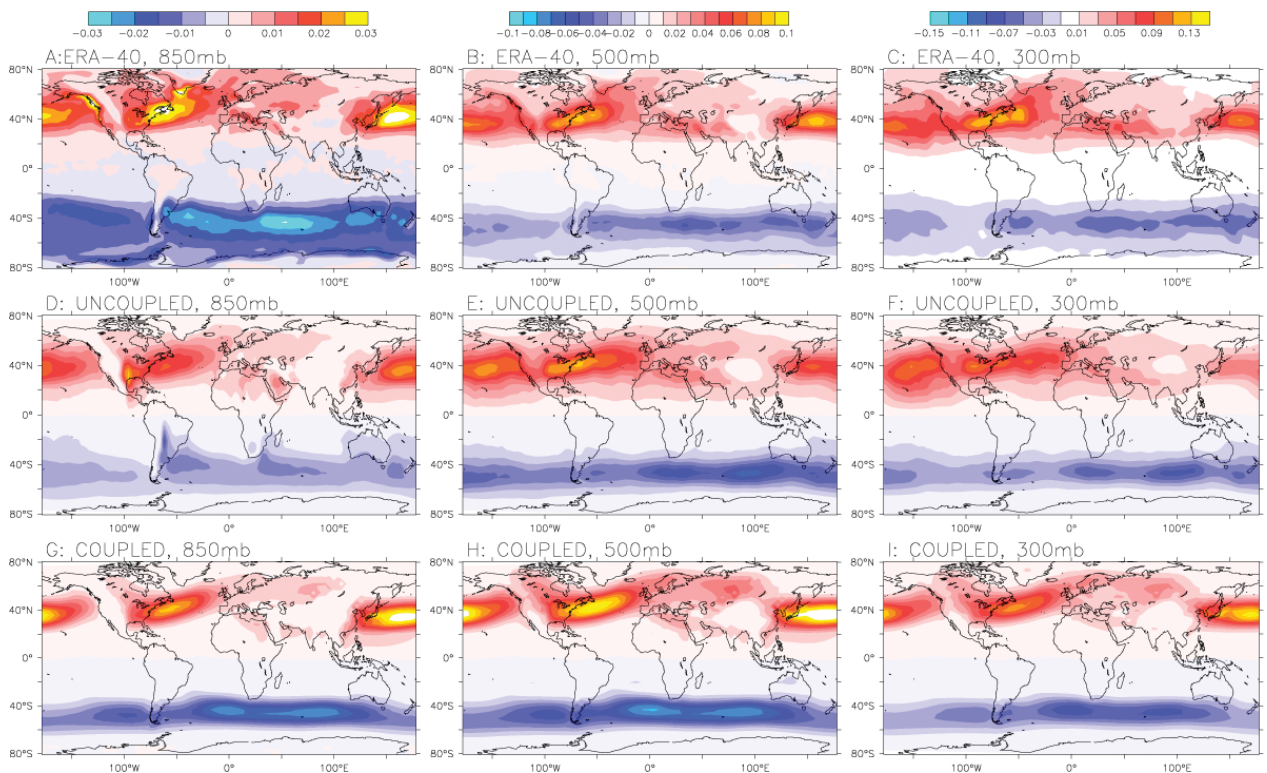
Fig. 7. Band-pass filtered ERA-40 data at (a) 850mb, (b) 500mb and (c) 300mb of h v 0 w 0 i (in m 2 s − 2 ) for December-January-February. (d–f) show results of “uncoupled” and (g–i) “coupled” experiments using Aeolus (Eq. 7) at same pressure levels.